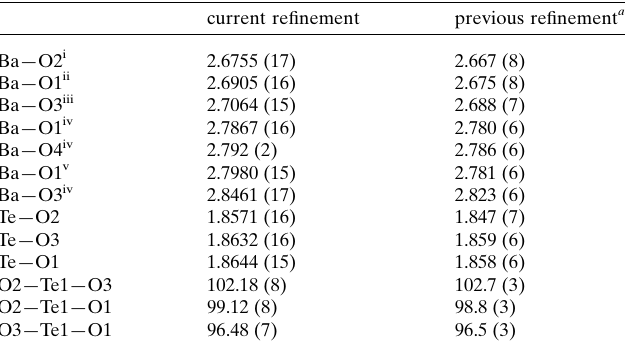
Table 1 Comparison of selected bond lengths (A˚ ) from the current and the previous (Nielsen et al. , 1971) refinement of BaTeO 3 (H 2